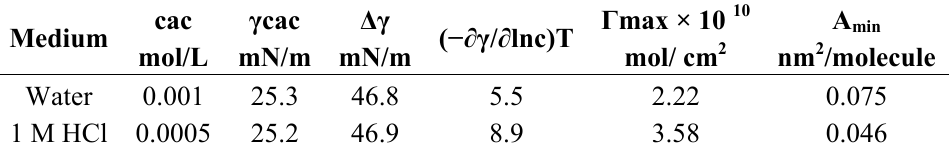
Table 1. Surface activity data of PAMPS-Na-co-St/magnetite composite in water and 1 M aqueous HCl